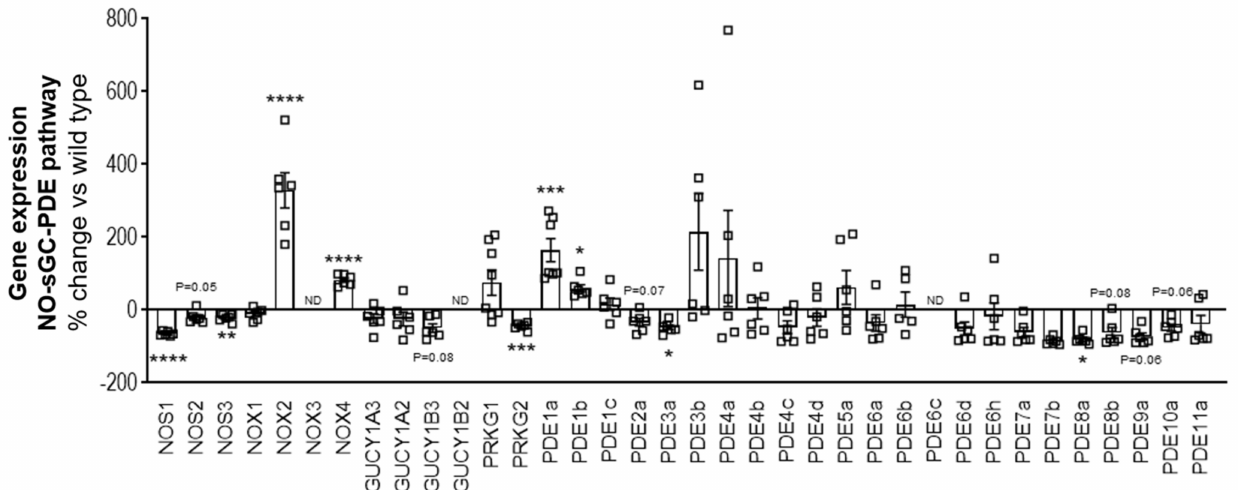
Figure 1. The NO-sGC-PDE pathway is largely downregulated in the skeletal muscle of mdx/mTR G2 mice. Fold change of mRNA expression of various genes in the NO-sGC-PDE signaling pathway in 22-week old mdx/mTR G2 versus wild type C57BL6/J mice in the quadriceps. All values are expressed as mean ± SEM. * p < 0.05; ** p < 0.01; *** p < 0.001; **** p < 0.0001; ns, not significant for unpaired t